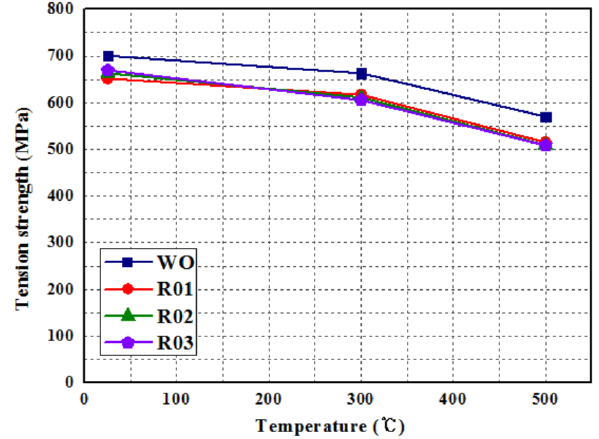
Figure 8. Results of the tensile strength test.